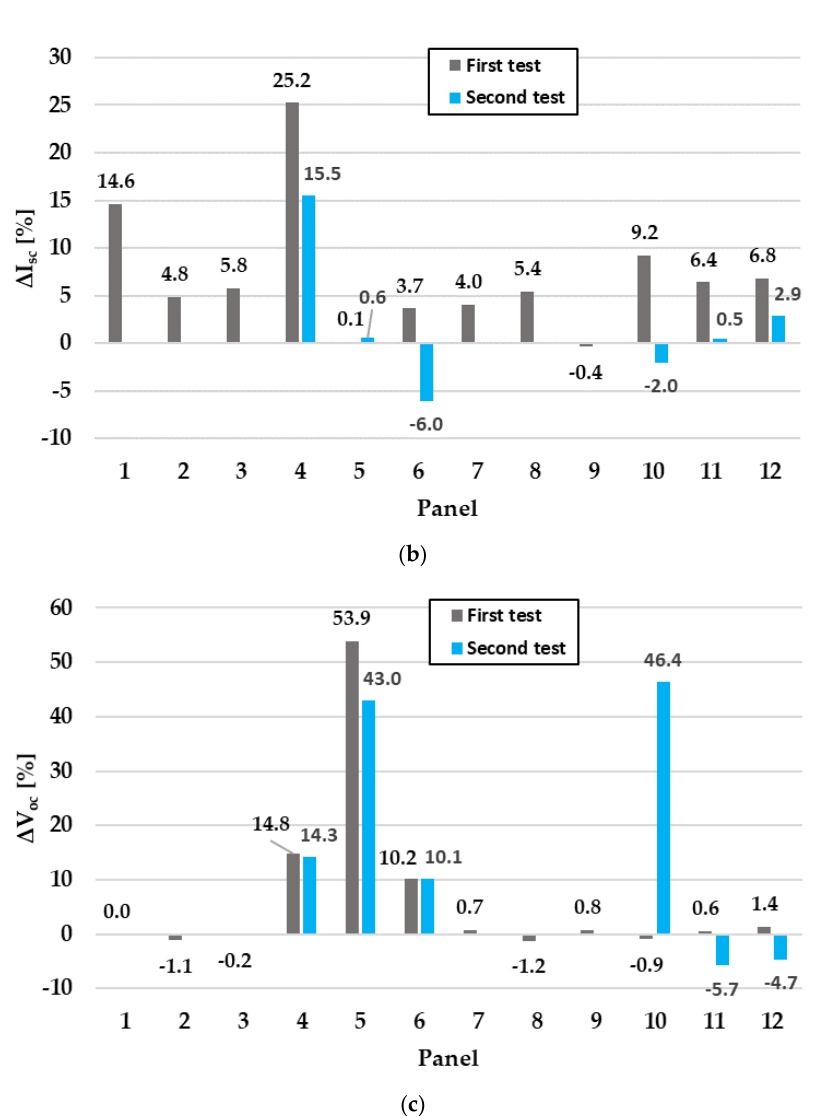
Figure 12. Percentage difference between expected simulated value and measured value for each panel: ( a ) efficiency; ( b ) short-circuit current; ( c ) open-circuit voltage.